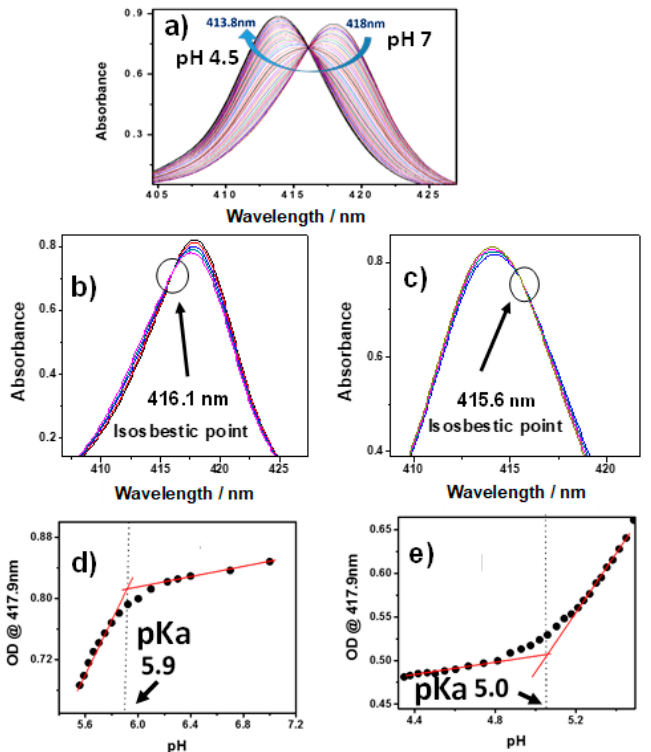
Figure 1. ( a ) Blue shifting of the λ max (Soret band) of SnTPyP (1.4 × 10 − 6 M in CH 3 CN/H 2 O (8/2, v / v )) in the pH region 7 to 4.5, ( b ) isosbestic point (circle) observed in the pH region 7–5.5, ( c ) isosbestic point (circle) observed in the pH region 5.5–4.2, ( d , e ) p K a value estimated from the inflection point in the plots between pH vs. OD at 417.9 nm in the pH region